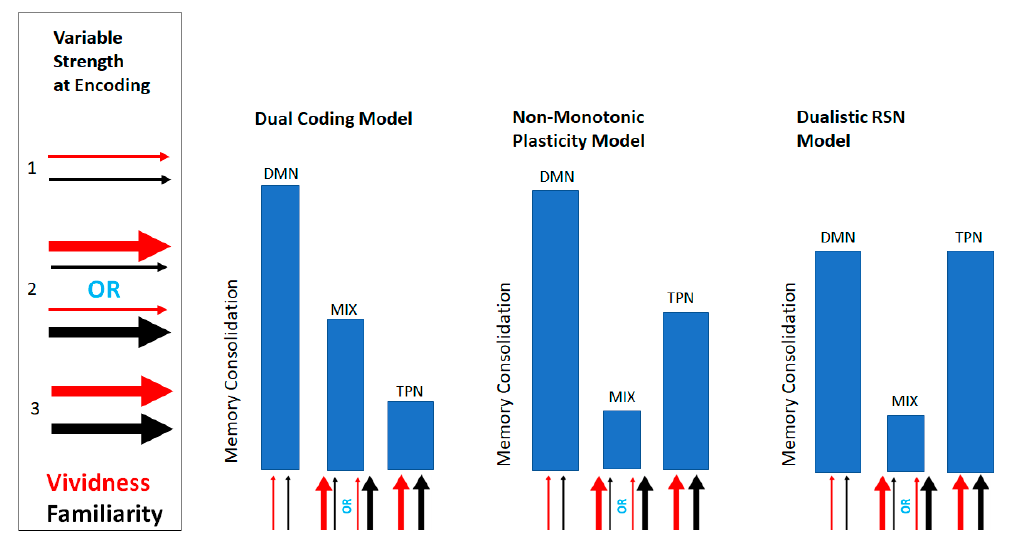
Figure A1. Schematic depicting the three contrasting models of memory consolidation. Each model depicts its predicted memory consolidation scores in relation to the three possible combinations of variable strength at the time of encoding. The width of the arrows signifies the strength of the variables at encoding.